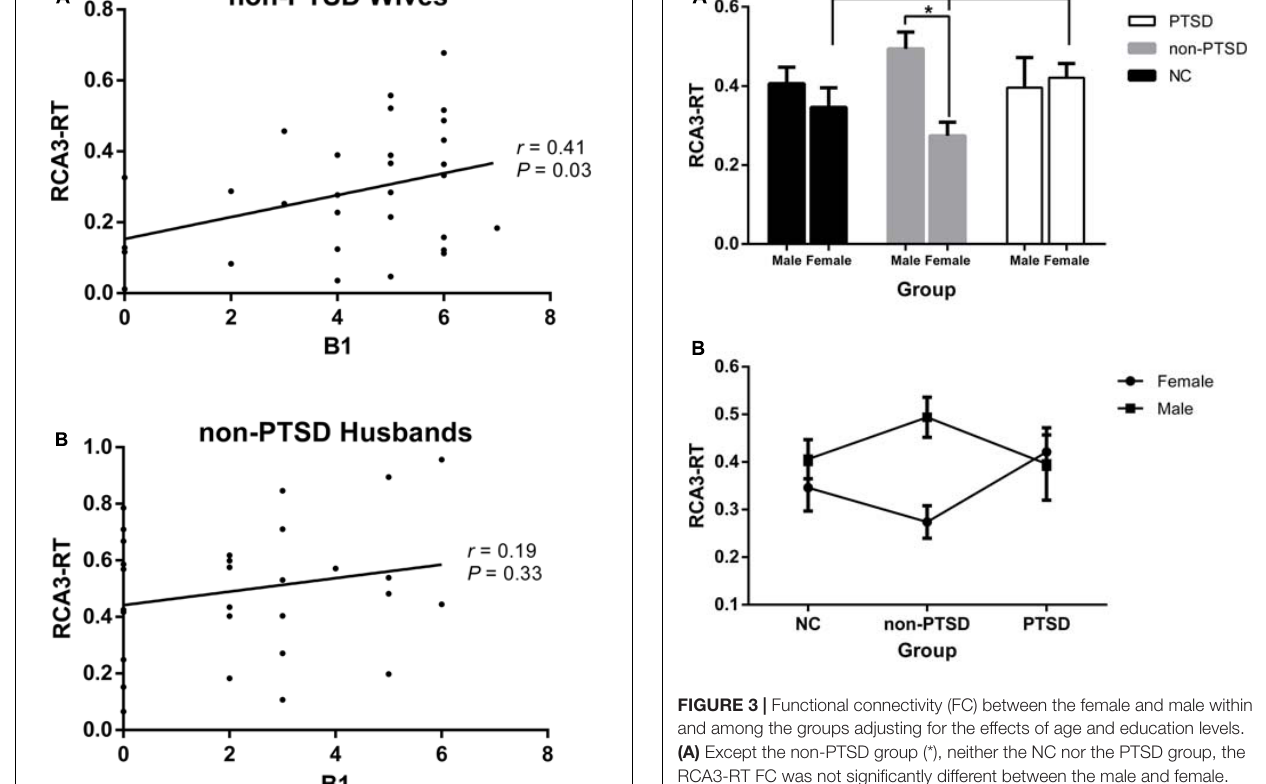
FIGURE 2 | The correlation between the re-experiencing symptom and the abnormal functional connectivity (FC) in the non-PTSD wives (A) and husbands (B) . Only the correlation between the RCA3-RT FC and B1 score was significant ( r = 0.41, P = 0.03) in the non-PTSD wives, but not in the non-PTSD husbands. RCA3-RT FC, the functional connectivity between right hippocampal CA3 and right thalamus; CA, Cornu Ammonis.